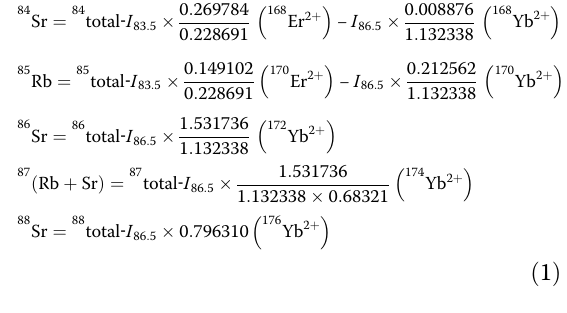
Rb interference